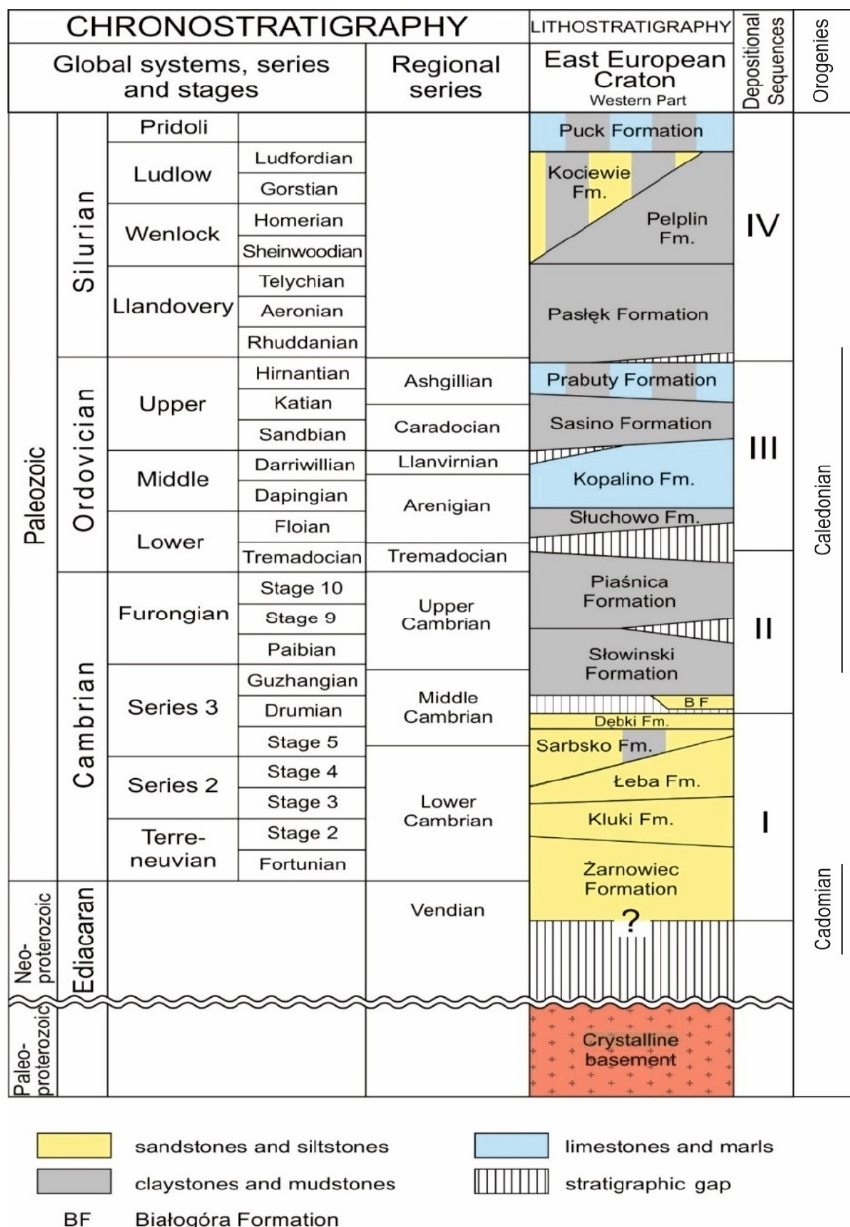
Figure 4. Chronostratigraphic column of Neoproterozoic–Lower Paleozoic sedimentary cover with indicated depositional sequences from the western part of the East European Craton (after [21,22]; simplified).